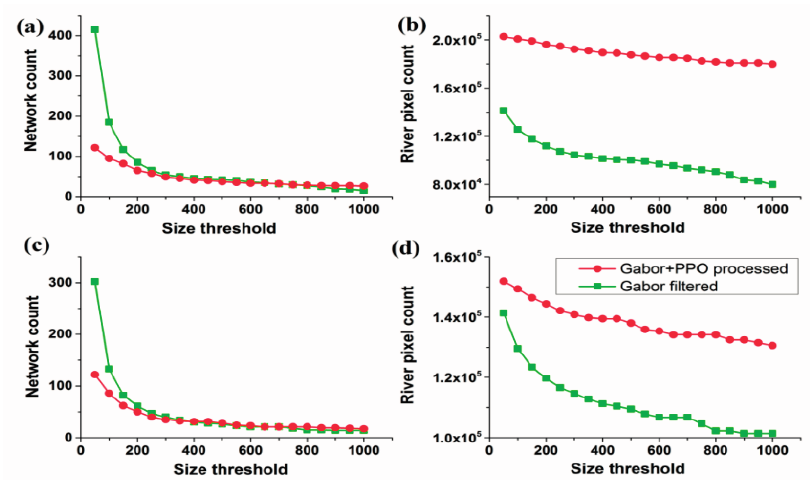
Figure 14. The network and river pixel counts under different size thresholds. ( a ) The network count and ( b ) the corresponding river pixel count for the classified Yukon images. ( c ) The network count and ( d ) the river pixel count for the classified GrIS